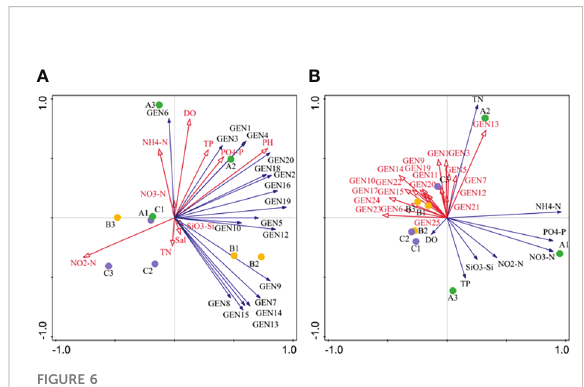
FIGURE 6 Redundancy anaysis (RDA) of phytoplankton community composition based on high-throughput sequencing for April (A) and June (B) communities. Abbreviations are as follows: GEN1: Bathycoccus prasinos , GEN2: Ostreococcus sp., GEN3: Micromonas pusilla , GEN4: Micromonas sp., GEN5: Pyramimonas australis , GEN6: Nannochloris sp., GEN7: Plagioselmis prolonga , GEN8: Teleaulaxamphioxeia , GEN9: Cryptomonadales sp., GEN10: Storeatula major , GEN11 Teleaulax minuta , GEN12: Geminigera cryophila , GEN13: Heterocapsa sp., GEN14: unclassi fi ed dino fl agellate, GEN15: Gymnodinium sp., GEN16: Skeletonema marinoi , GEN17: Skeletonema costatum , GEN18: Thalasssiosira rotula , GEN19: Thalassiosira tenera GEN20: Minidiscus comicus , GEN21: Cerataulina pelagica ,